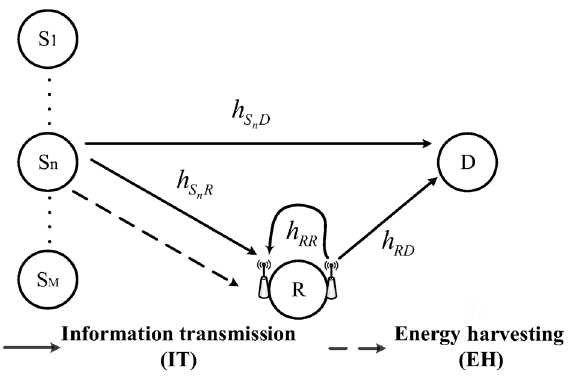
Fig. 1. System model.